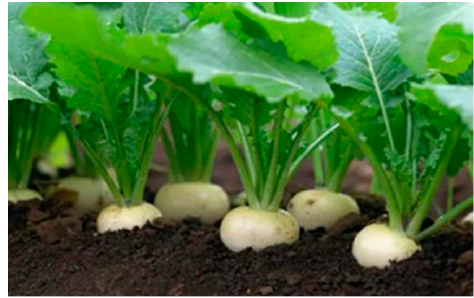
Figure 2. Turnip ( Brassica L.).